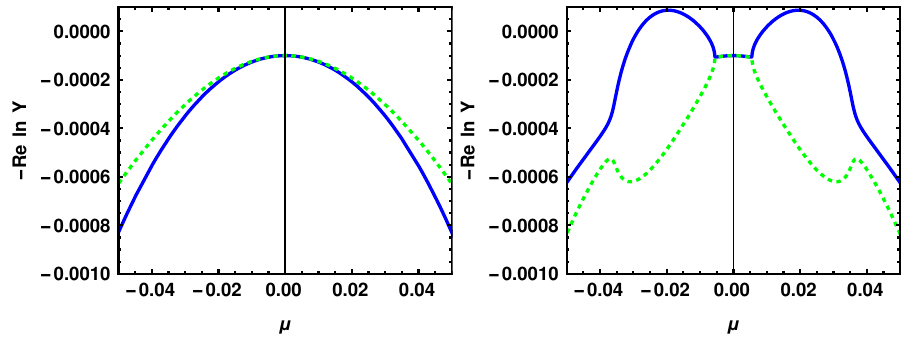
Figure 5. Curves of pseudocontinuous spectrum in the limit of large delay (21) of (12) of the CW with the largest intensity ( | A 0 | ≈ 0.0178 out of another two | A 0 | ≈ 0.0156 and | A 0 | ≈ 0.0065) near the LLE limit with β = 1/2 (left) and β = 1/2 (right), and η ≈ 1.797 × 10 − 6 . Other parameters are as in Figure